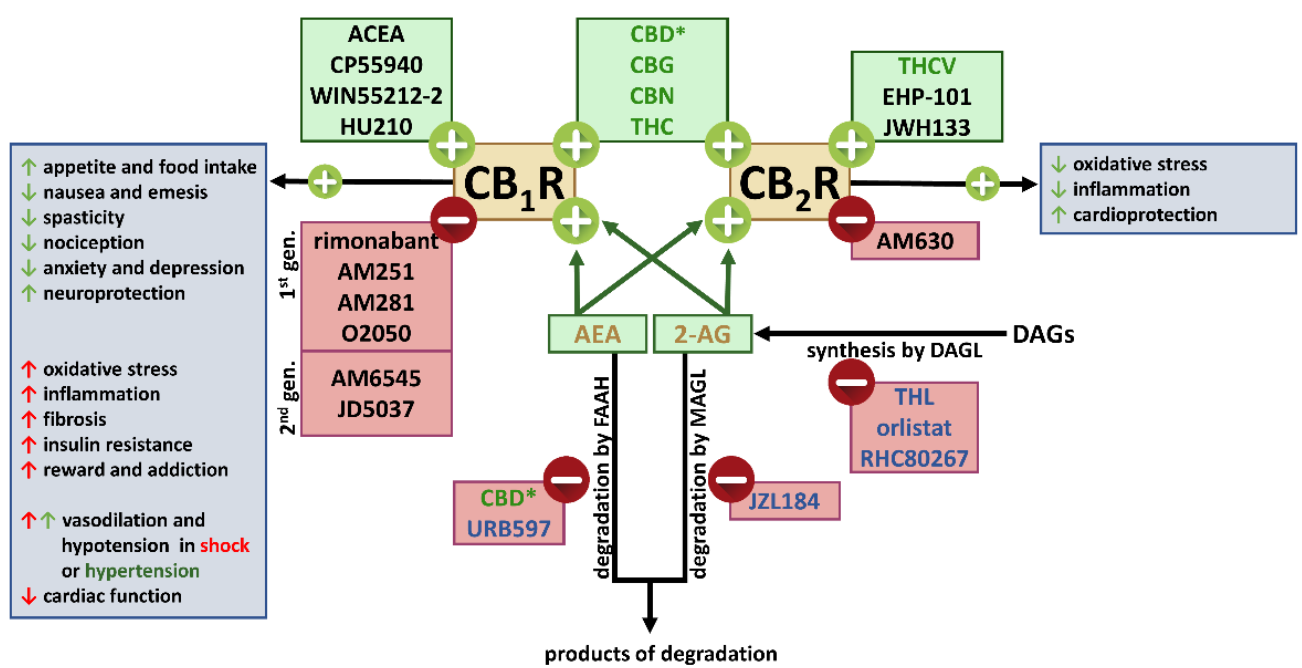
Figure 2. Simplified diagram of compounds modifying the (endo)cannabinoid system as far as they are considered in this review. The ECS comprises endocannabinoids such as anandamide (AEA), 2-arachidonoylglycerol (2-AG), enzymes for their biosynthesis [diacylglycerol lipase (DAGL)] and degradation [fatty acid amide hydrolase (FAAH), and monoacylglycerol lipase (MAGL)] and cannabinoid receptors (CB 1 R, CB 2 R). Green circles with a plus sign describe (partial) agonism at the respective receptor; red circles with a minus sign describe antagonism, inverse agonism, or inhibition at the respective mechanism. Synthetic, plant-derived compounds and endocannabinoids are written in black, green, and brown font, respectively; the blue font is for enzyme inhibitors. Up arrows, increase; down arrows, decrease; green arrows, desired effects; red arrows, undesired effects. 1st gen., first-generation antagonists; 2nd gen., second-generation antagonists; * weak affinity. ACEA, Arachidonyl-2’-chloroethylamide; CBD, cannabidiol; CBG, cannabigerol; CBN, cannabinol; DAGs, diacylglycerols; THC, ∆ 9 -tetrahydrocannabinol; THCV, tetrahydrocannabivarin; THL, tetrahydrolipstatin.